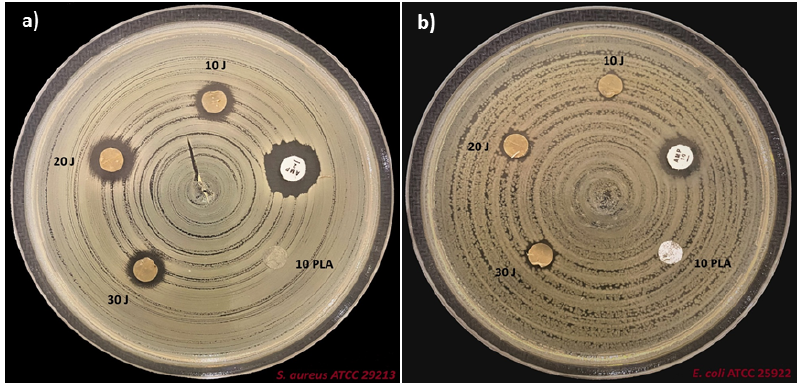
Figure 6. Antimicrobial properties of the scaffolds against the S. aureus ( a ) and E. coli ( b ). Table 2. Antimicrobial results of the PLA and PLA/J scaffolds. E. coli ATCC 25922 Scaffolds